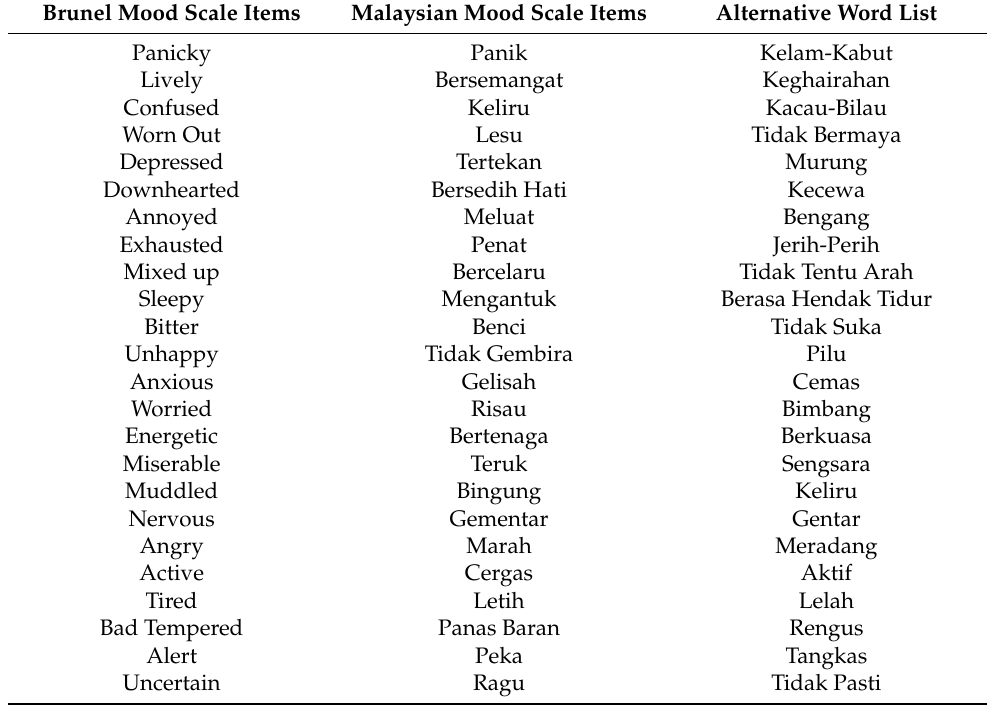
Table A2. Alternative Word List for the Malaysian Mood